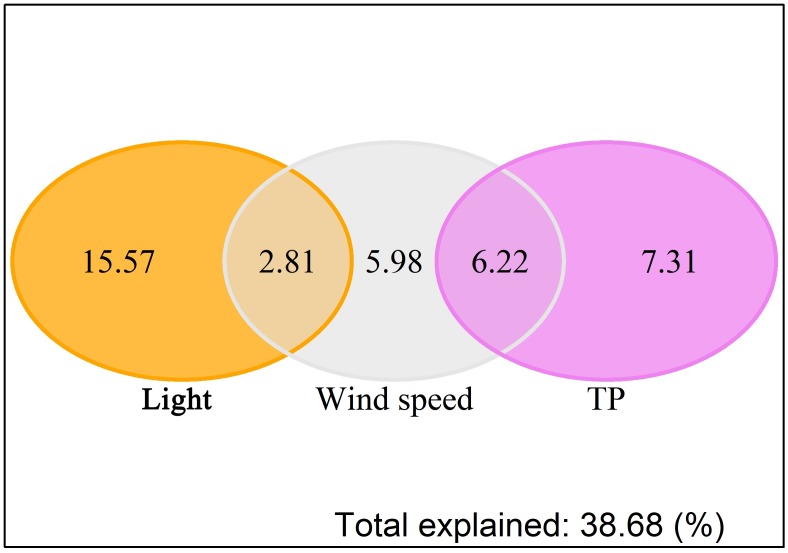
Venn diagram representing the result of the pRDA analyses.Amount of variation in phytoplankton groups biovolume explained by light condition, wind speed, TP and their interactions. Each area is proportional to the share of the inertia explained by the single factor or its interactions with other corresponding factors. Numbers correspond to the percentage of the explained variation associated with each variable type. Negative values are not shown.